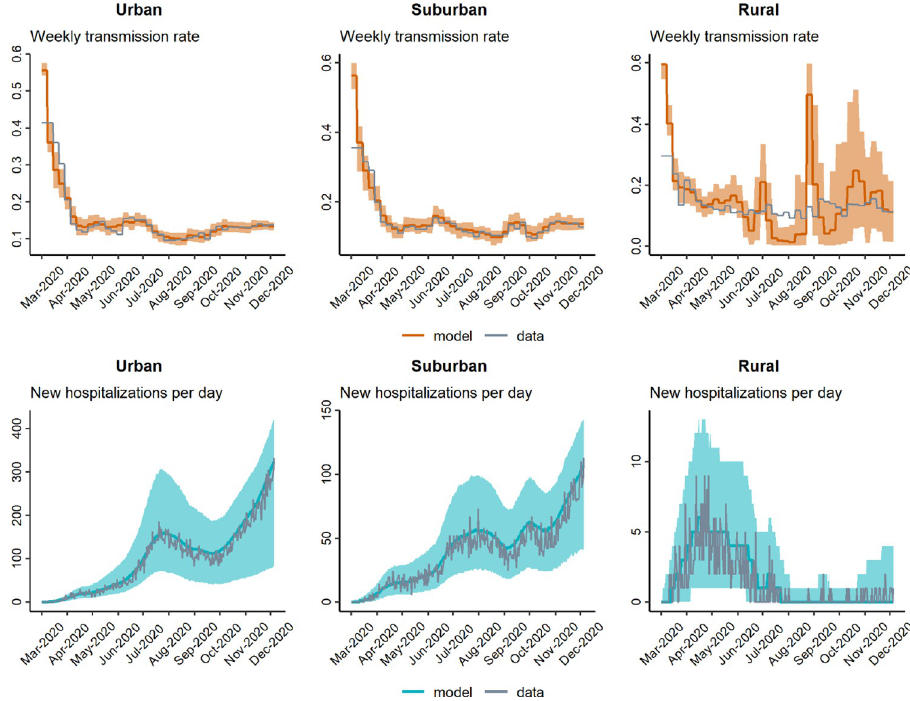
Fig 5. Model-fitting of weekly transmission rate β known values.